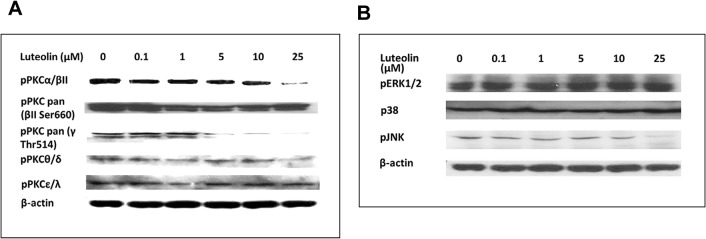
Luteolin attenuated PKCs and MAPKs.WRL-68 cells were cultured and treated with various concentrations of luteolin. After 24 h of treatment, the cell lysates were immunoblotted for Protein Kinase Cs (Fig 5A) and Mitogen Activated Protein Kinases (Fig 5B). The images represent one of two independent experiments with comparable results.